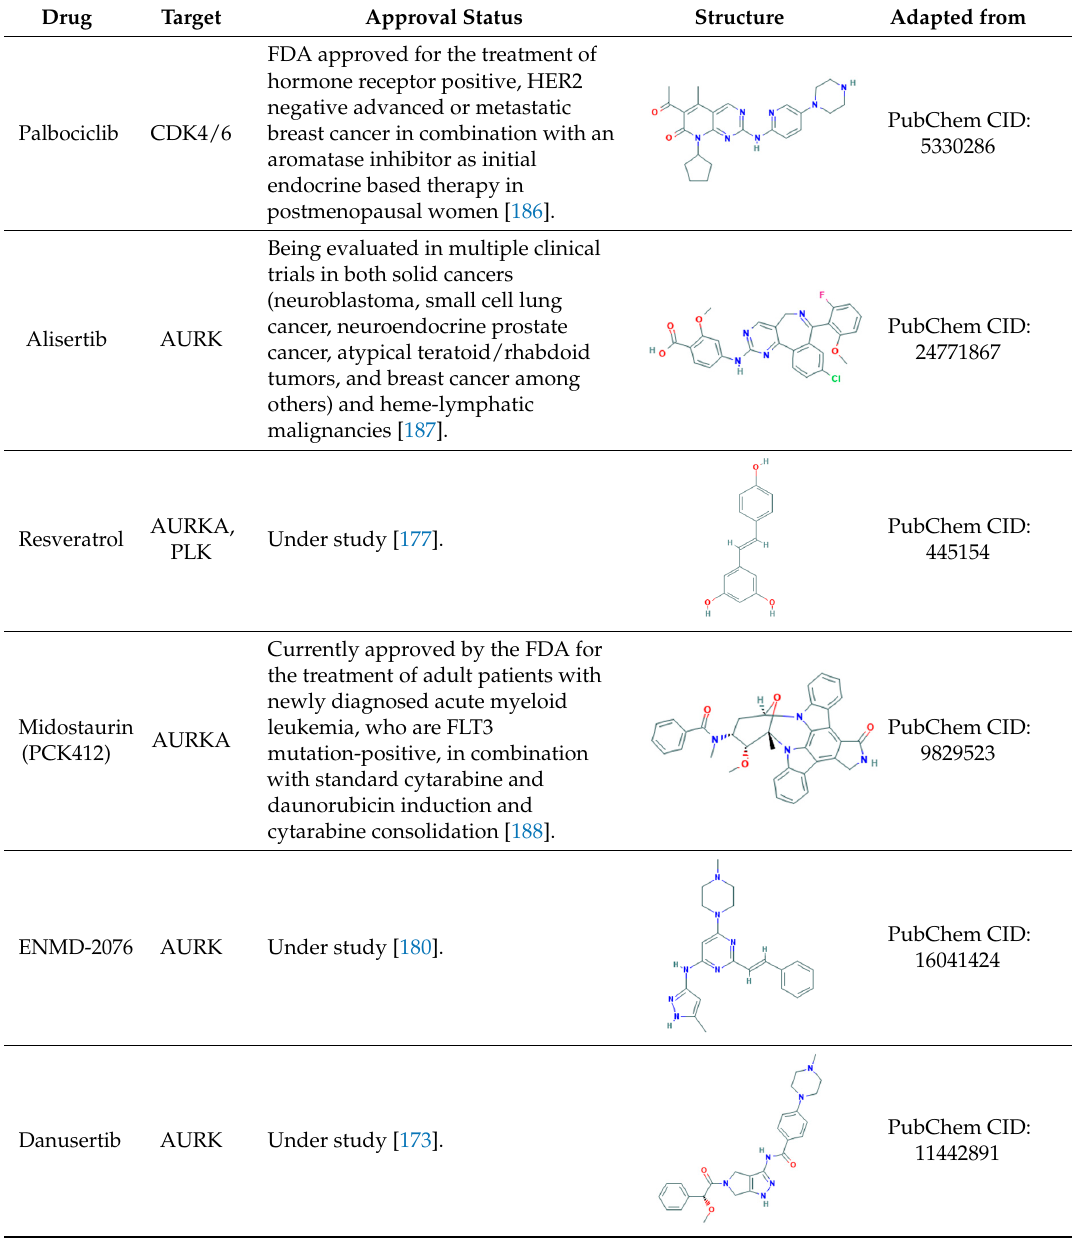
Table 13. Cell Cycle Proteins Inhibitors.